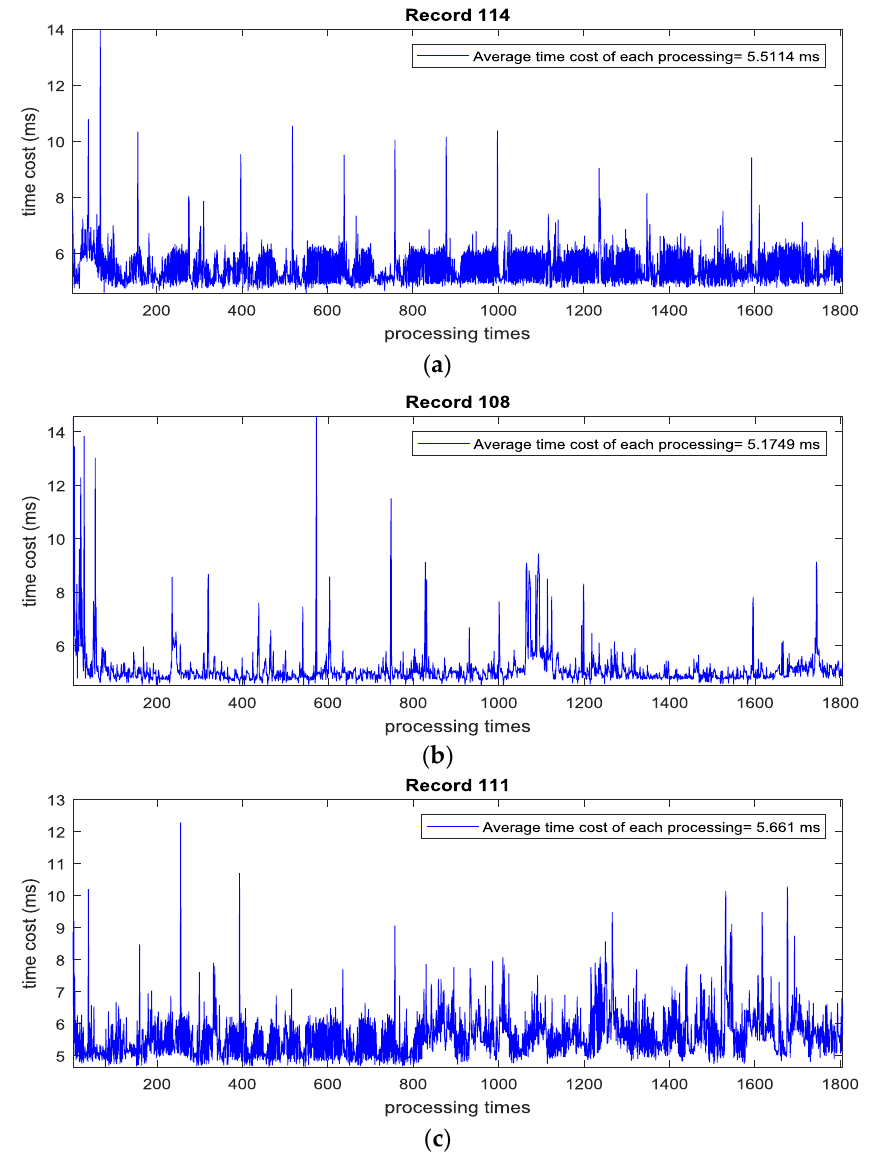
Figure 13. The time cost for processing each two-second length ECG signal: ( a ) Time cost of each processing in Record 114; ( b ) Time cost of each processing in Record 108; ( c ) Time cost of each processing in Record 111.